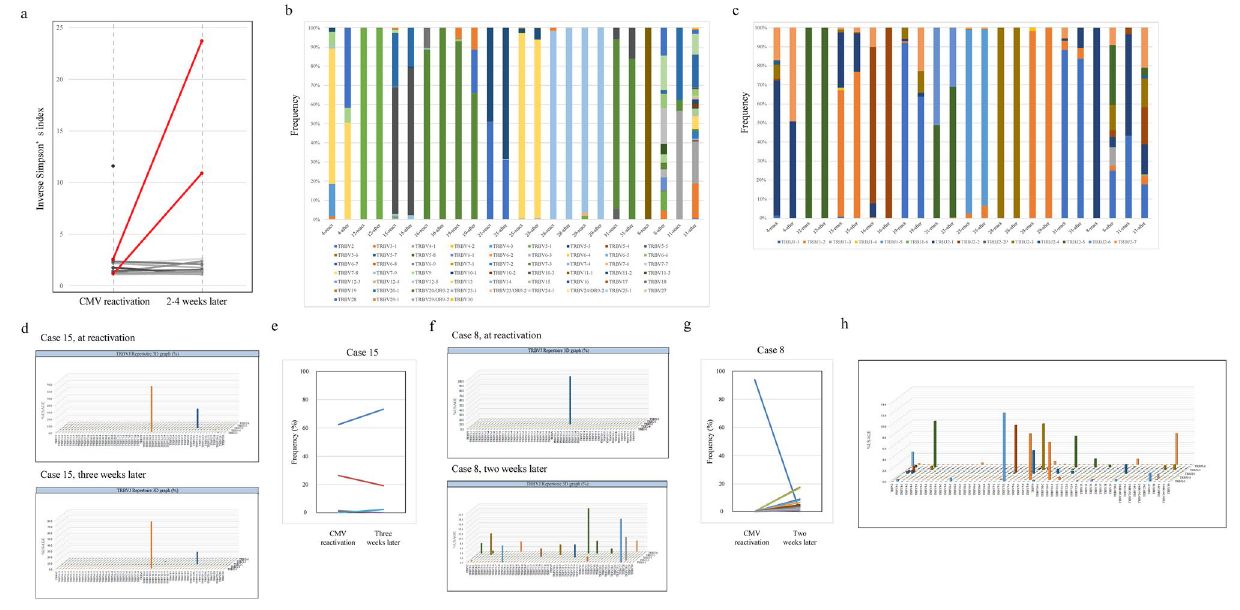
Figure 5. Clonal dynamics of CMV-CTLs. ( a ) T-cell receptor-beta repertoire of cytomegalovirus-specific cytotoxic T-cells (CMV-CTLs) and its changes over time. Two cases with remarkable changes in diversity are highlighted in red. ( b , c ) Frequency of each TRBV ( b ) and TRBJ ( c ). ( d ) A 3D graphical plot of T-cell repertoire of CMV-CTLs at the time of CMV reactivation (above) and 3 weeks after (below) for Case 15. ( e ) Frequency and time course for each CMV-CTL clonotype in Case 15. Clonotypes that accounted for ≥ 1% were represented. ( f ) 3D graphical plot of T-cell repertoire of CMV-CTLs at the time of CMV reactivation (above) and 2 weeks after (below) for Case 8. ( g ) Frequency and time course for each CMV-CTL clonotype in Case 8. Clonotypes that accounted for ≥ 1% were represented. ( h ) A 3D graphical representation of the TCR repertoire of CMV-CTLs 2–4 weeks after CMV